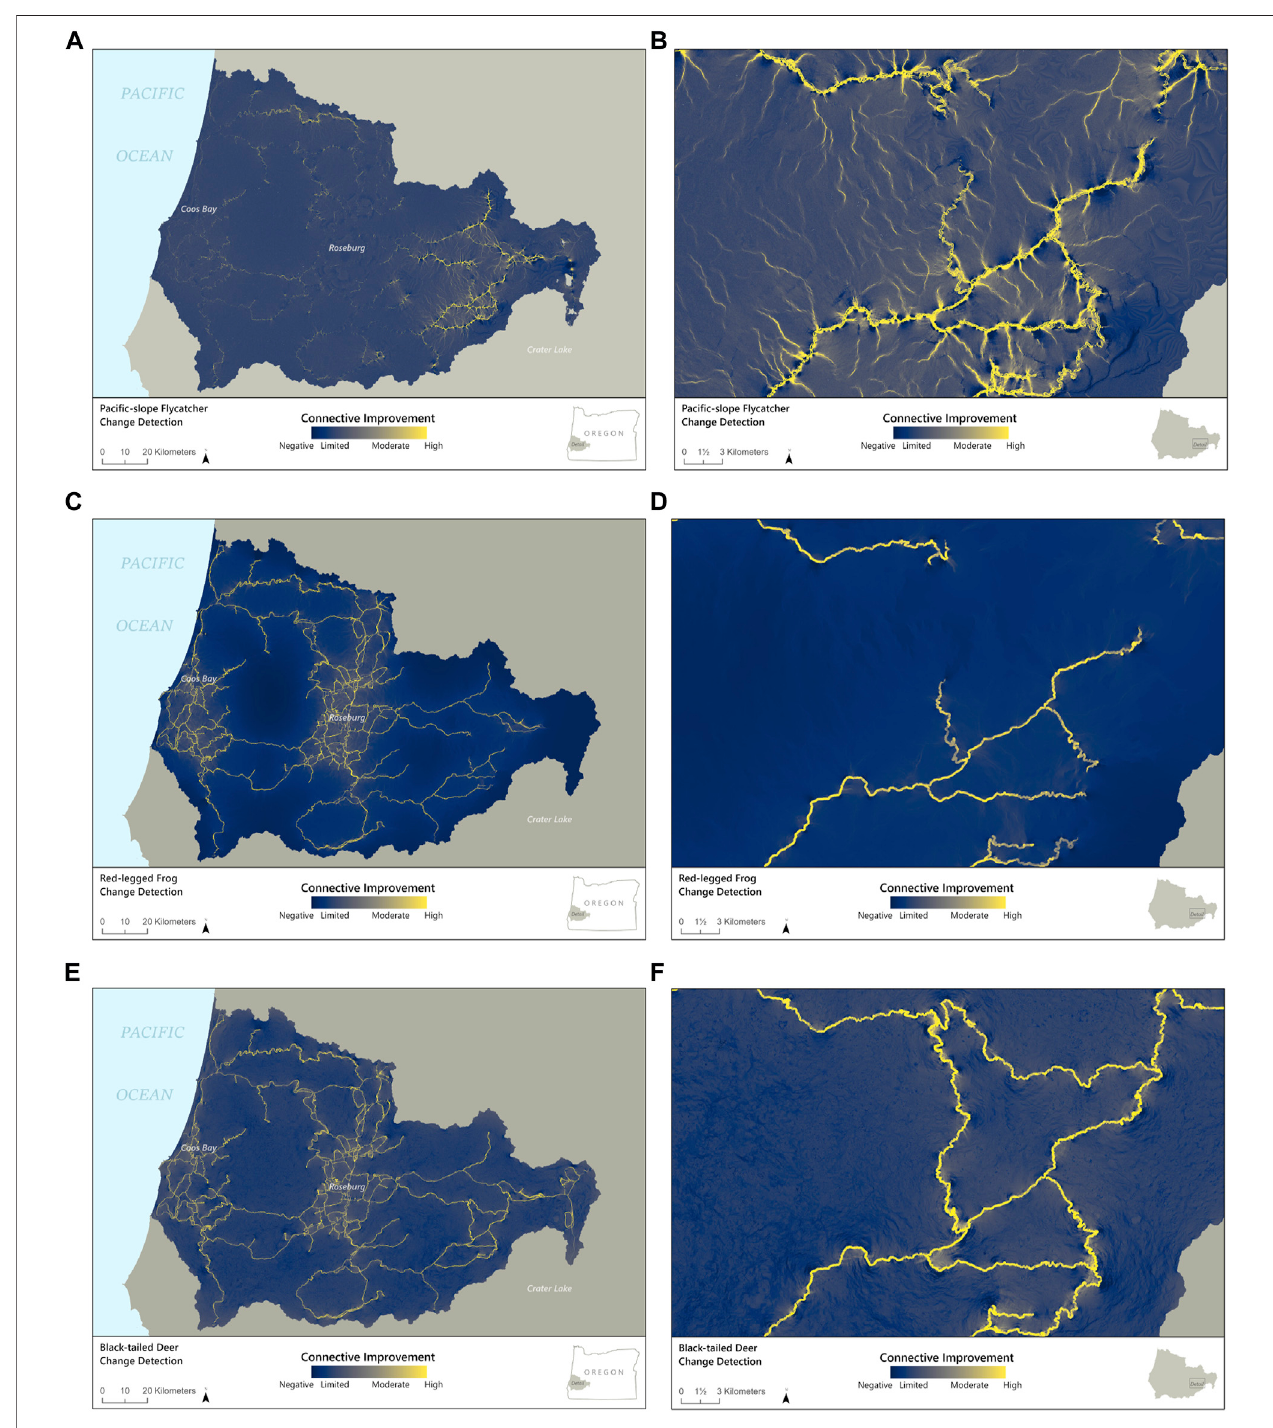
FIGURE 5 | Maps showing the difference in detected connectivity between Omniscape models with roads subtracted from models without roads for (A) Paci fi c- slope fl ycatcher throughout the study area and (B) zoomed in on a portion of the eastern side of the study area; (C) red-legged frog for the whole study area and (D) zoomed inon theeastern portion,and (E) Columbian black-taileddeer forthe wholestudyarea and (F) zoomed inon theeastern portion.The darkblue areas represent low improvement from modeled removal of roads whereas, at the other end of the color scheme, yellow represents high current improvement for the “ No Road ” scenario compared to the “ Road ”